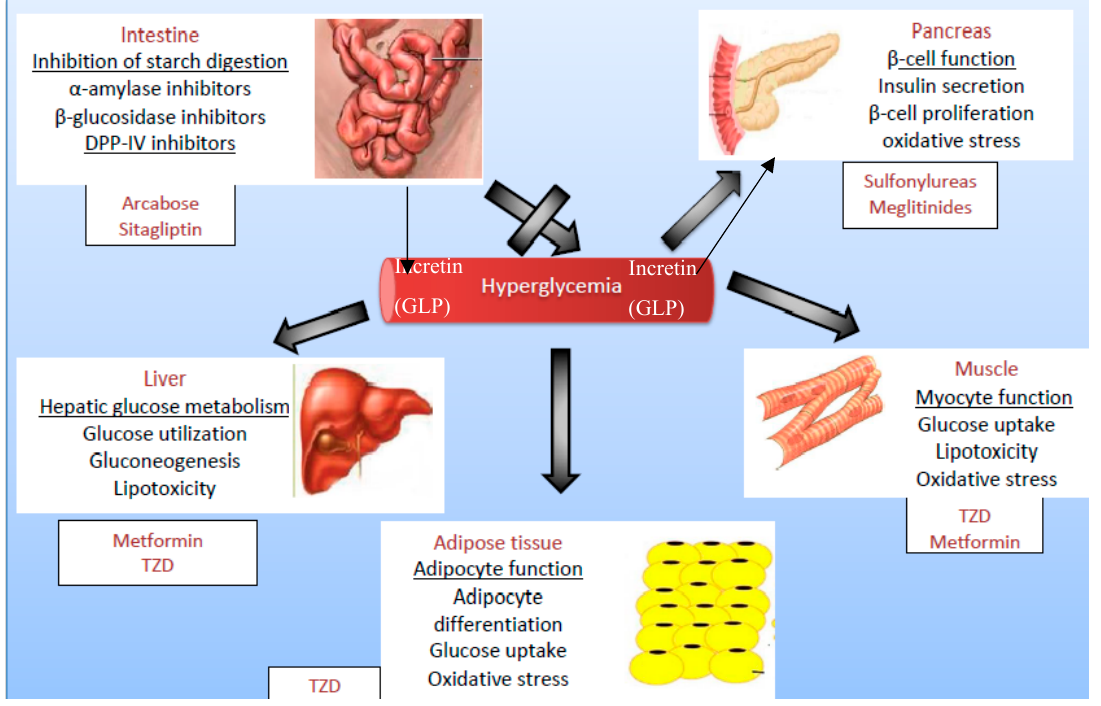
Figure 1. Summary of therapeutic targets for the management of diabetes mellitus. TZD = Figure 1. Summaryoftherapeutictargetsforthemanagementofdiabetesmellitus. TZD=Thiazolidinedione. Thiazolidinedione. DPP-IV: Dipeptidyl peptidase IV; GLP: Glucagon-like peptide 1. DPP-IV: Dipeptidyl peptidase IV; GLP: Glucagon-like peptide